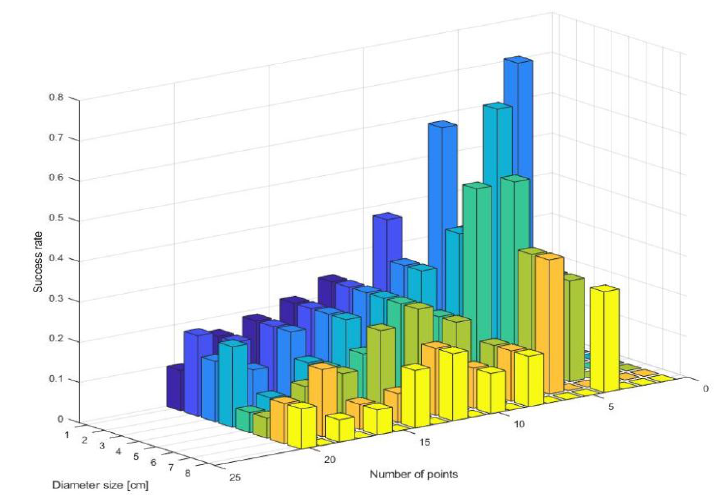
Figure 4. Statistical analysis of scene recoverability. The plot shows the probability of correctly imaging all targets in a scene of spheres randomly placed in a volume of 10 cubic meters. The number of spheres varies from five to 20 and the sphere diameter from 1 to 8 cm. The plot is generated from simulated data using the realistic parameters of detector and photon noise and assuming a 10 W illumination pulse from the